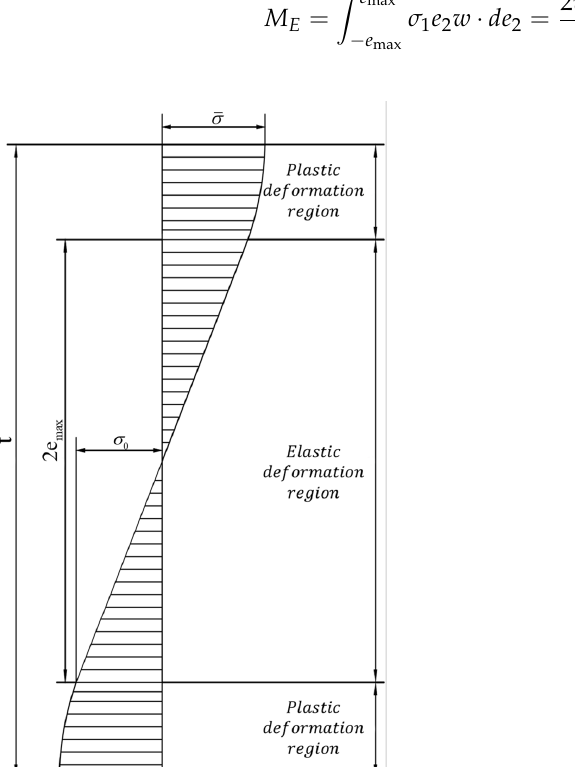
Figure 9. Stress distribution along sheet thickness direction. For the stress in the elastic district as in Figure 9, based on Equations (24) and (26), the plastic bending moment can be expressed as Equation (28):